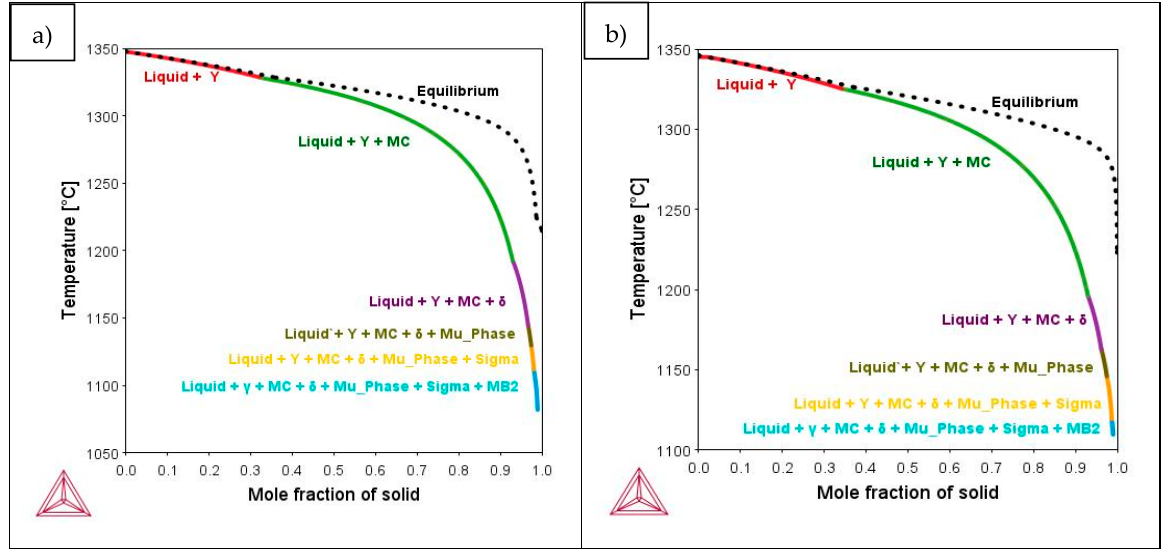
Figure 13 . Scheil-Gulliver simulations of ( a ) LPW and ( b ) A&D samples. Figure 13. Scheil-Gulliver simulations of ( a ) LPW and ( b ) A&D